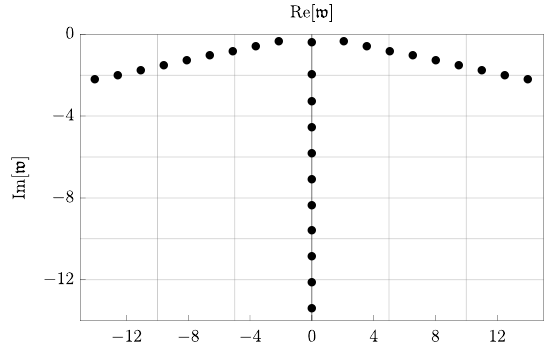
Figure 7 . The scalar channel quasinormal spectrum of the O ( (cid:11) 2 ) theory with q = 0, plotted for (cid:11) = 0 : 02 and (cid:13) 2 = (cid:0) 0 :